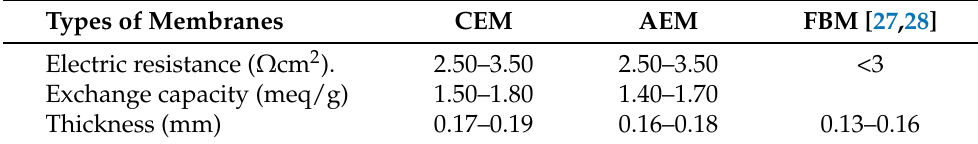
Table 1. Membrane characteristics.